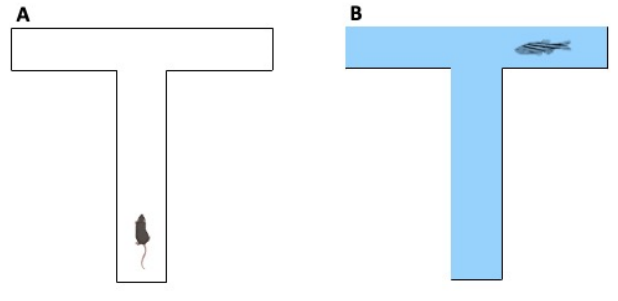
Figure 16. The T-maze test. ( A ) Test in mice; ( B ) test in zebrafish.